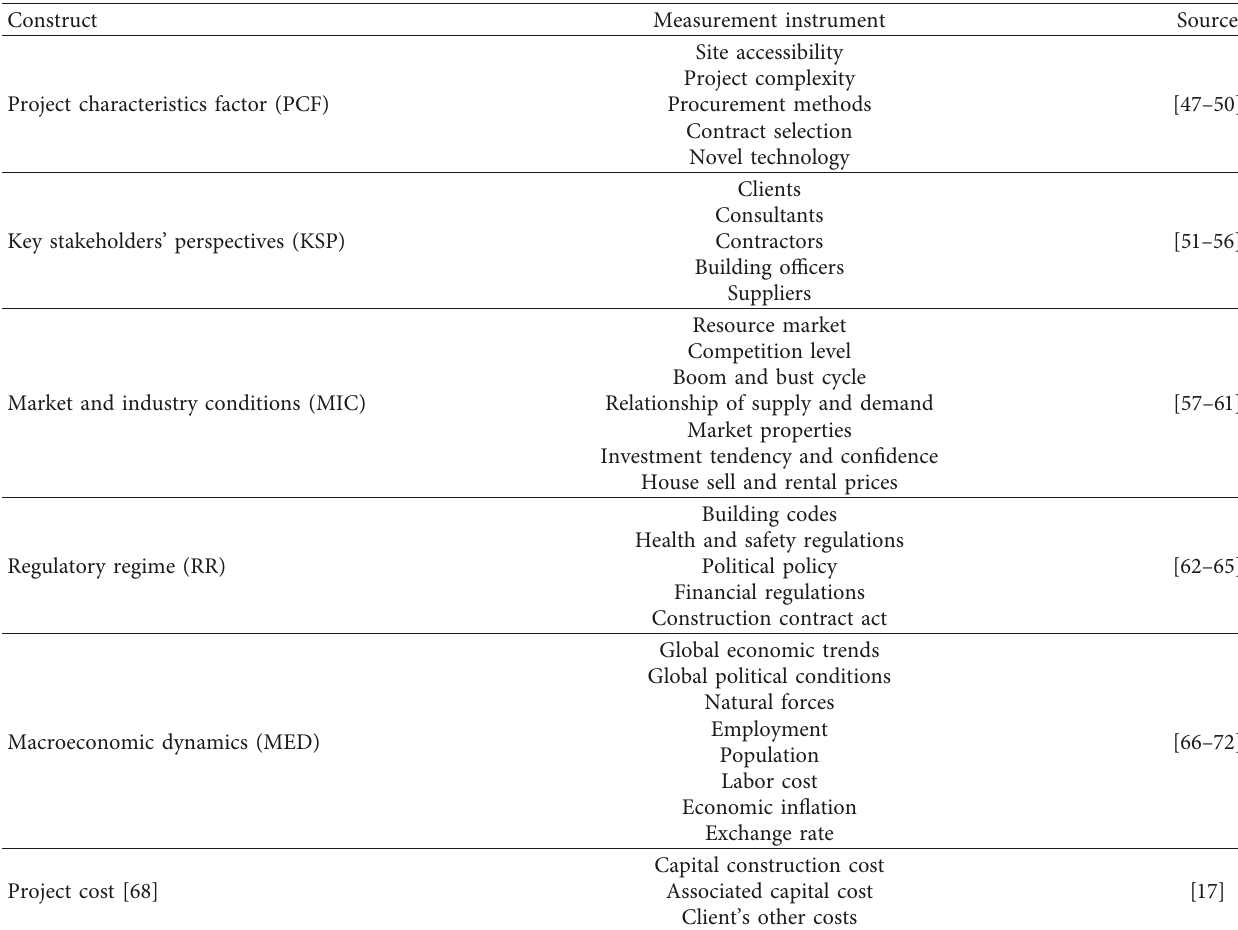
Table 1: Categories of the influential